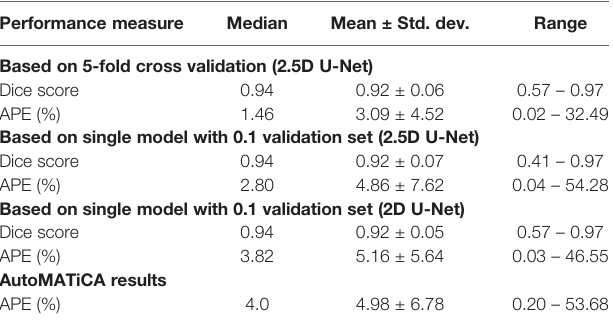
TABLE 3 | Performance on test data set using 2.5D/2D